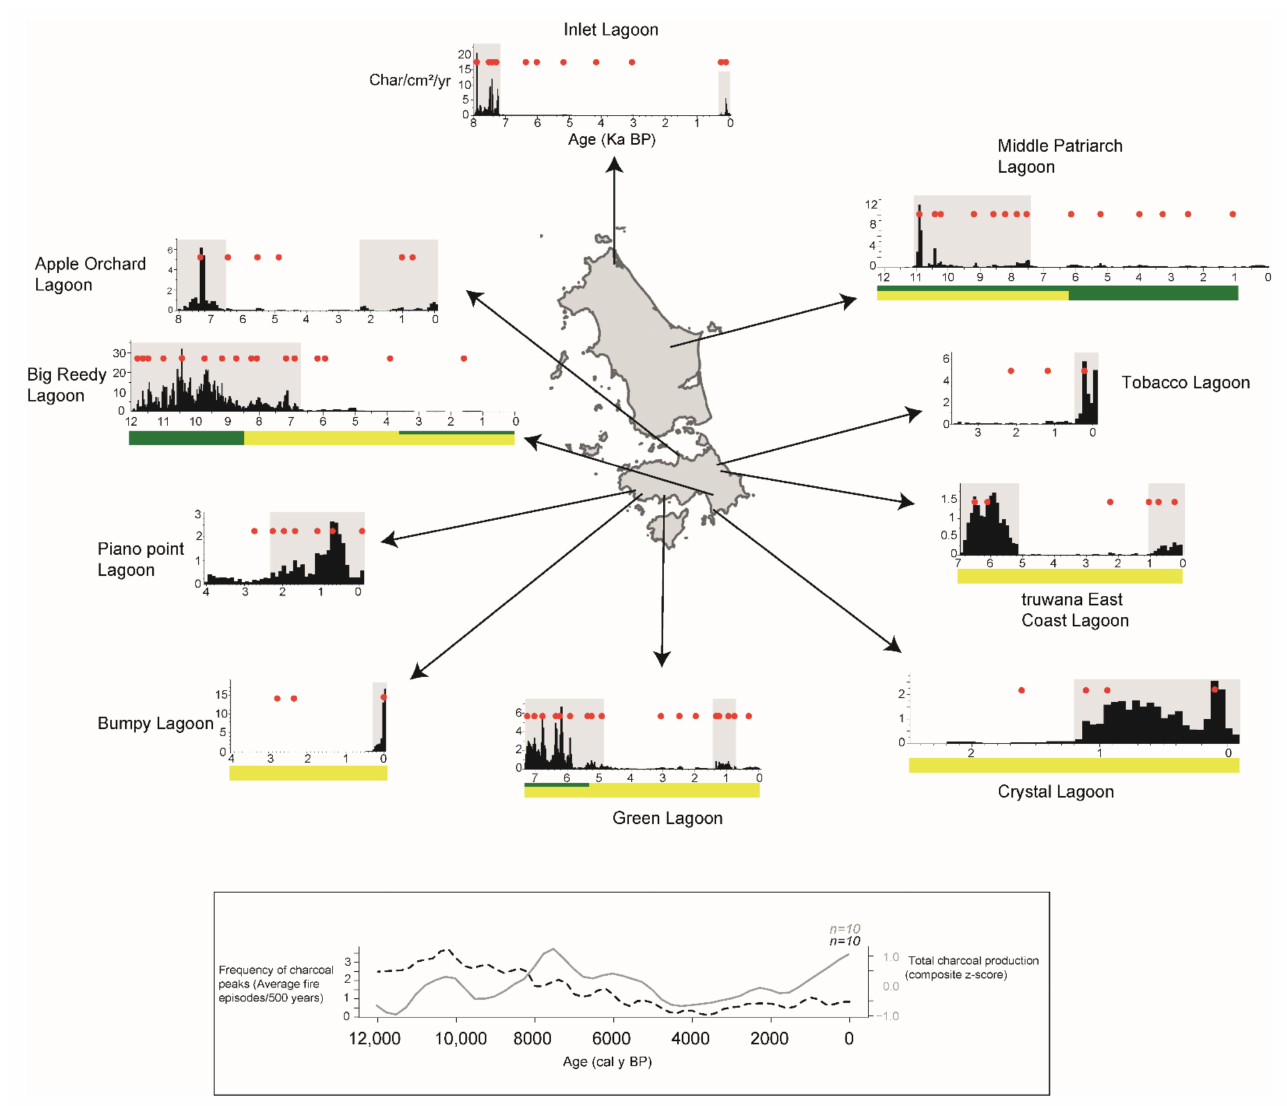
Figure 2. Charcoal accumulation rates with charcoal peaks (red dots) for each site on the Furneaux Group islands, Bass Strait. Periods of major fire activity (high charcoal accumulation) during the early–mid Holocene and late Holocene are shaded in grey. Colour bars represent temporal vegetation types, which include woodland (green) and a combination of heath and scrub (yellow) [52,53,72]. The horizontal axis in each record represents age (calendar years before present, i.e., 1950 AD). The rectangular box shows the composite of all charcoal records’—regional biomass burned (grey curve) and frequency of charcoal peaks—recurrence rates of fire episodes (black dashed curve) for the Furneaux